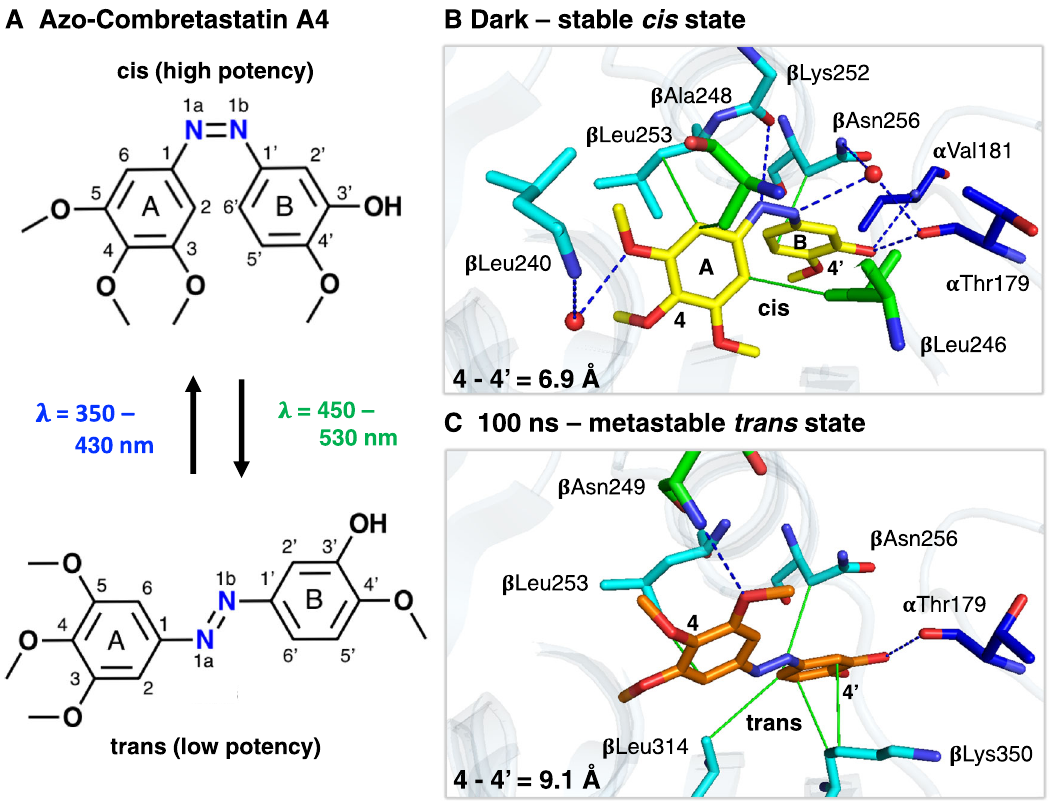
β T7 loop (green) of β -tubulin. Hydrophobic interactions (green lines) between tubulin residues and the A and B rings of cis -azo-CA4 as well as hydrophilic inter- actions (blue dashed lines) toward the ring substituents anchor the ligand within thecolchicinesite. C Withinnanosecondsafterillumination, trans -azo-CA4(orange sticks) has relaxed into a metastable binding pose with an altered interaction net- work and reduced af fi nity. For clarity, only interacting residues are